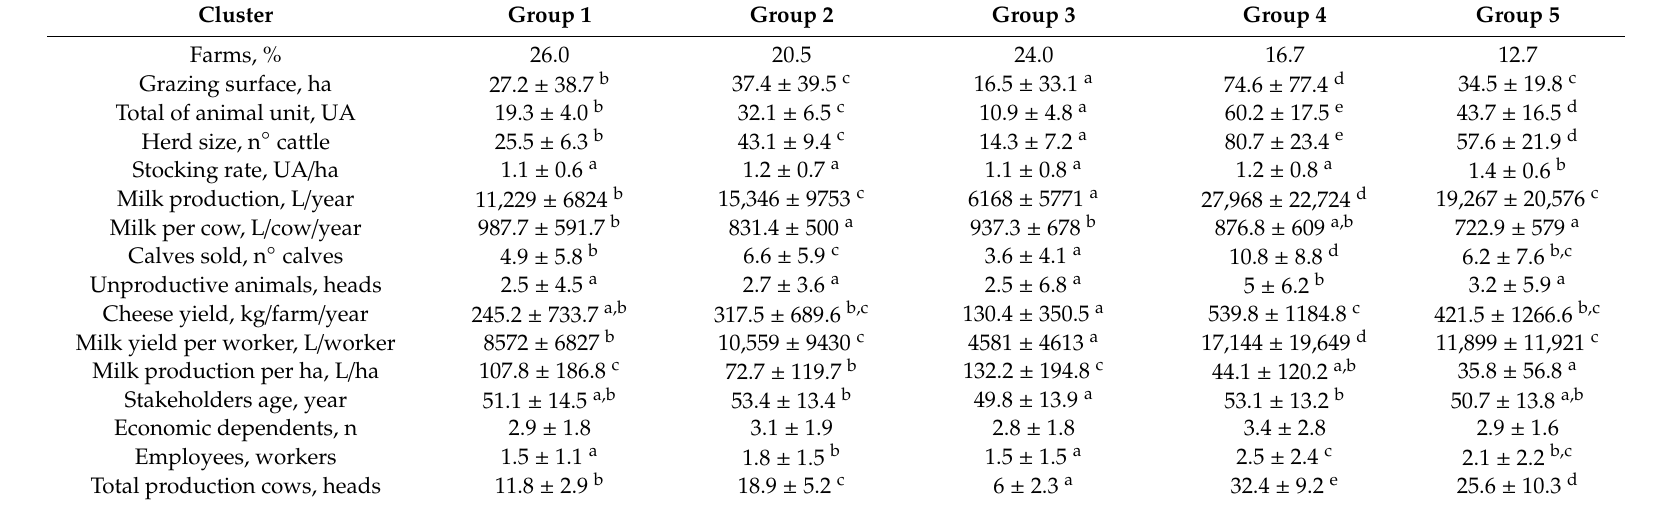
Table 3. Structural characteristics and performance for each group of smallholder dual-purpose